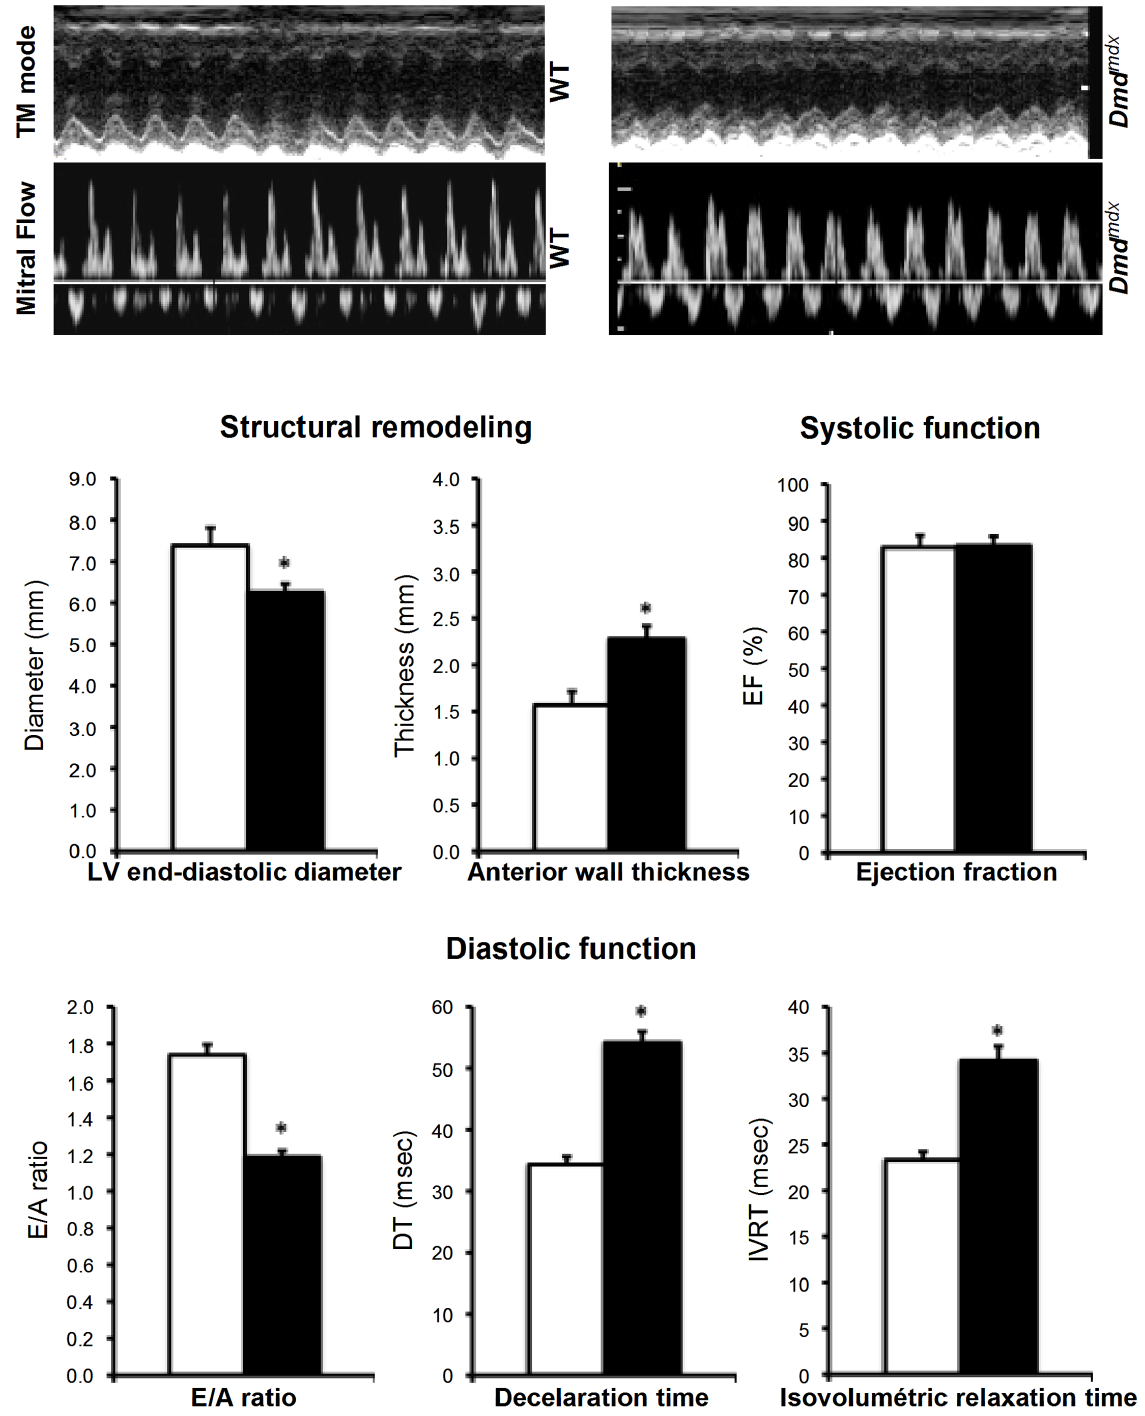
Figure 6. Structural remodelling and altered diastolic function in hearts of Dmd mdx rats. Echocardiography was performed on 3 month-old Dmd mdx rats. The structural remodeling and the systolic and diastolic functions were assessed respectively by Two-dimensional (2-D) echocardiography and pulsed Doppler (n=6 for each condition); Values are mean 6 SEM; *p , 0.05). (TM mode: Time movement mode; LV: Left ventricular; E/A ratio: early diastolic (E)/late diastolic (A) ratio). doi:10.1371/journal.pone.0110371.g006 toxicity and allowed to induce Dmd gene mutations as expected newborns and among them 11 showed mutations (3.74% of the [9–12]. transferred zygotes and 12.5% of newborns). These results are The Dmd mutations observed in newborn rats were deletions similar to our previous ones injecting other engineered sequence- ranging from 1 to 24 bp and insertions of a few nucleotides specific nucleases and thus Dmd TALENs did not trigger embryo